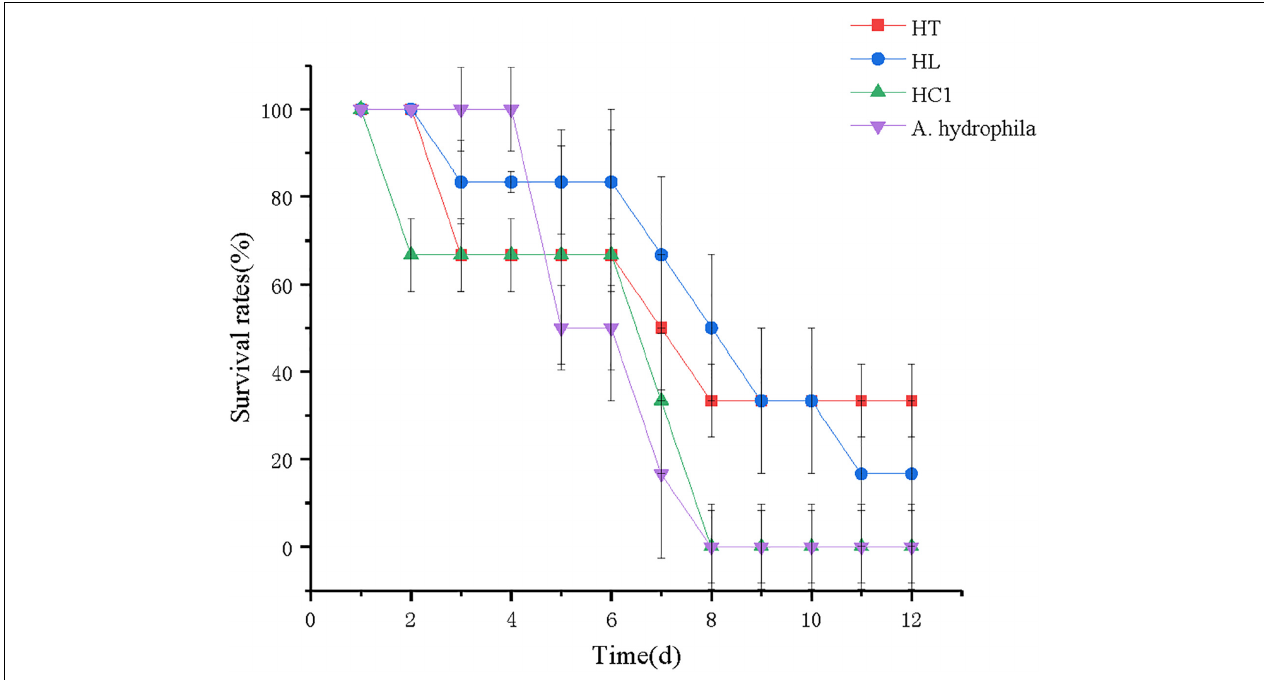
FIGURE 6 | Survival rates of crucian carp ( Carassius auratus ) fed with experimental diets. HC: The control group, HT: The L. lactis 1,209 treatment group, HL: The L. lactis 1,242 treatment group, A. hydrophila : The A. hydrophila ATCC 7,966 treatment